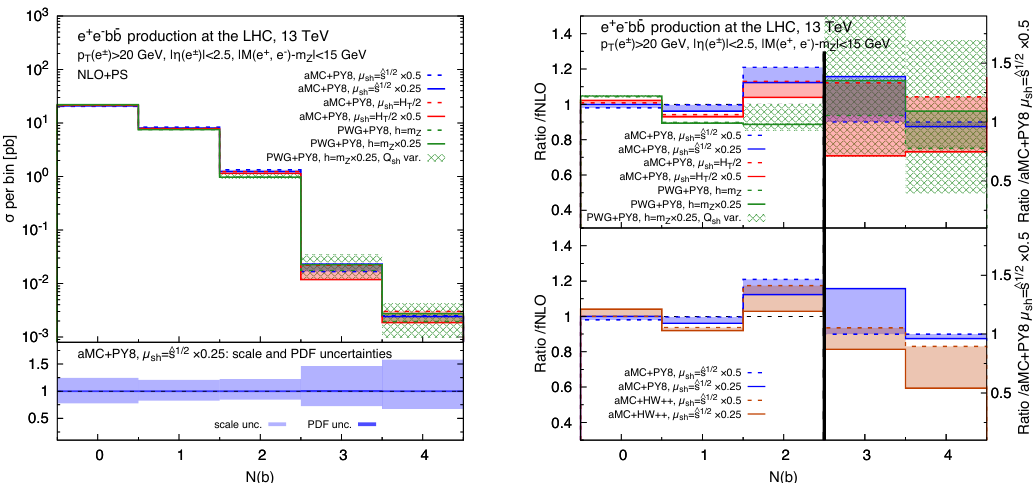
Figure 16 . The exclusive b -jet multiplicities. Same colour codes and approximations of (cid:12)gure 5. due to a migration of events from the 1-jet to the 2-jets bin. Even if the absolute number of events that migrate is not large, the percentage e(cid:11)ect is large, of O (+20%), because of the steeply-falling shape of the distribution. The hard recoil of the ‘ + ‘ (cid:0) b (cid:22) b system, compared to the (cid:12)xed-order prediction, in MG5 aMC at intermediate transverse momentum values (see (cid:12)gure 5) may explain the larger number of events with both b quarks passing the b -jet